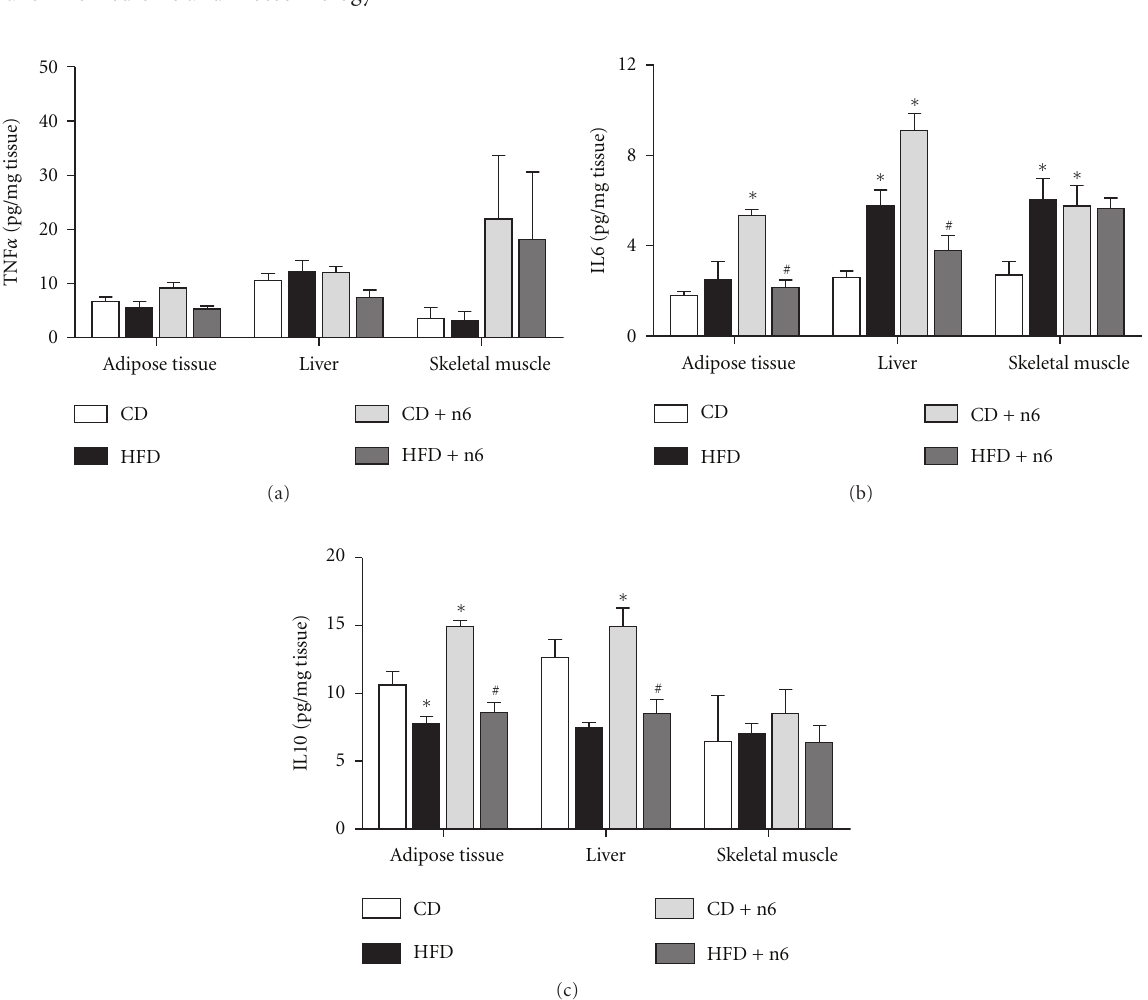
Figure 3: Tissue cytokine concentrations of TNF α (a), IL6 (b), and IL10 (c) in adipose tissue (retroperitoneal), liver, and gastrocnemius skeletal muscle from mice treated with control diet (CD) or high-fat diet (HFD), supplemented or not with sunflower oil (rich in n-6 fatty acids). Oral supplementation with n-6 (2g/Kg body weight, three times a week, gavage) or water started four weeks before HFD and continued until the end of experiment. Animals were feed with HFD or CD for eight weeks. Cytokines were measured in tissue homogenate. Values are expressed as pg/mg protein. Mean ± SEM ( n = 4–6). The statistical analysis was performed using two-way ANOVA with Bonferroni post tests. ∗ P < 0 . 05 when compared with CD; # P < 0 . 05 when compared with CD +